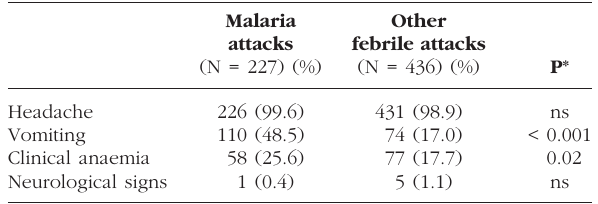
Table I. – Clinical signs associated with malaria attacks or febrile access.